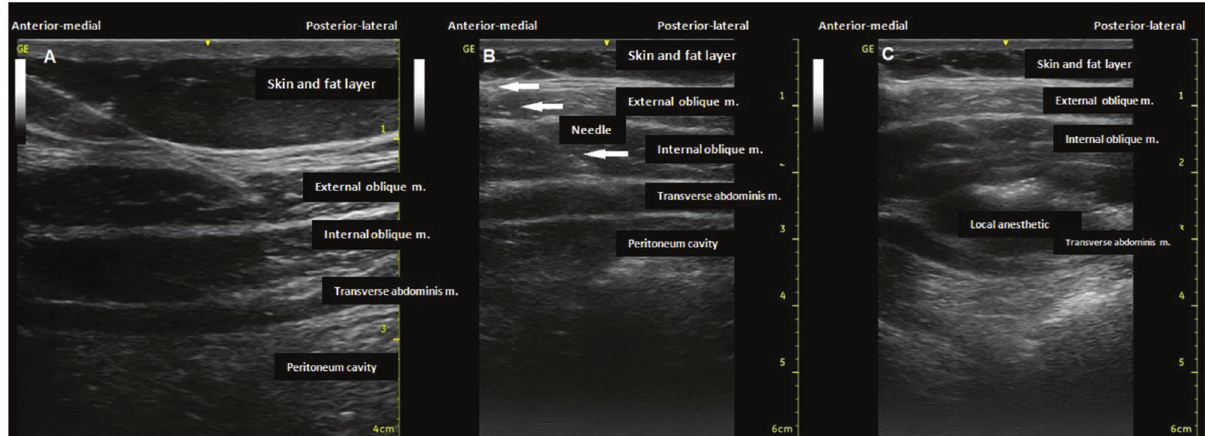
Figure 4 - A. Muscle planes visualized during TAP block execution. B. Needle with tip located between IO and TA muscles, C. Local anesthetic spread in the plane between IO and TA